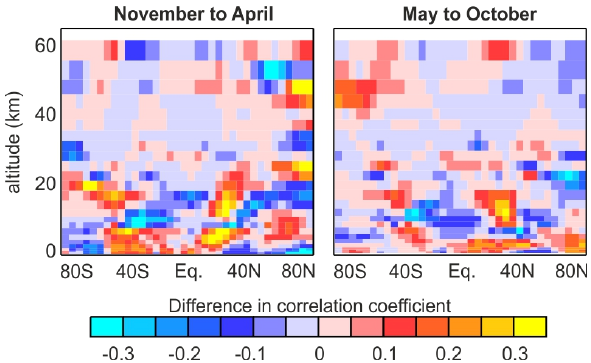
Fig. 8. Difference in the Pearson correlation coefficient between r (HISTOZ, BDBP) and r ( x b , BDBP) for the ensemble mean for boreal winter and summer periods.